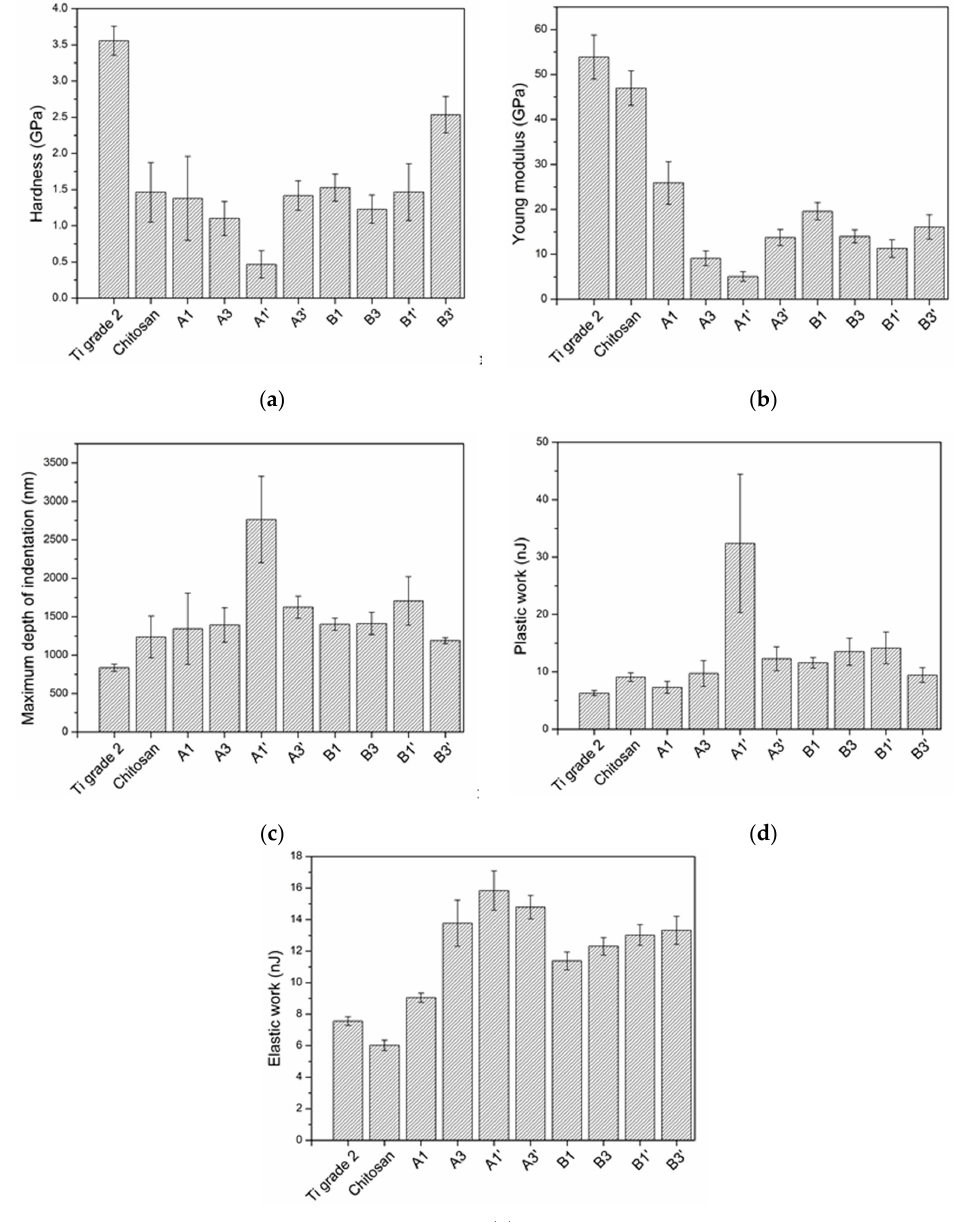
Figure 5. Mechanical properties: ( a ) hardness and ( b ) Young’s modulus; nanoindentation properties: ( c ) maximum depth of indentation, ( d ) plastic work and ( e ) elastic work for the Ti grade 2 substrate, the chitosan coating, and the chit/EE100 coatings. Data are presented as the mean ± SD ( n = 10). The Ti grade 2 substrate showed the highest hardness and Young’s modulus, which resulted in the smallest indentation depth obtained. All coated samples showed worse mechanical properties,